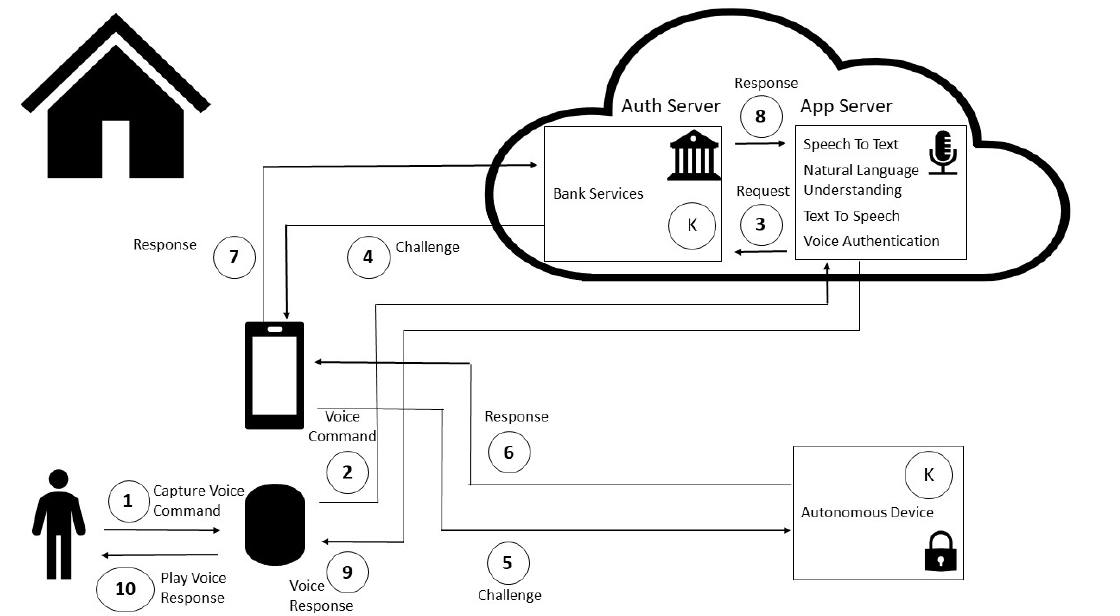
Figure 2. Open Smart Speaker Architecture with non-invasive Authorization that is based on data-driven